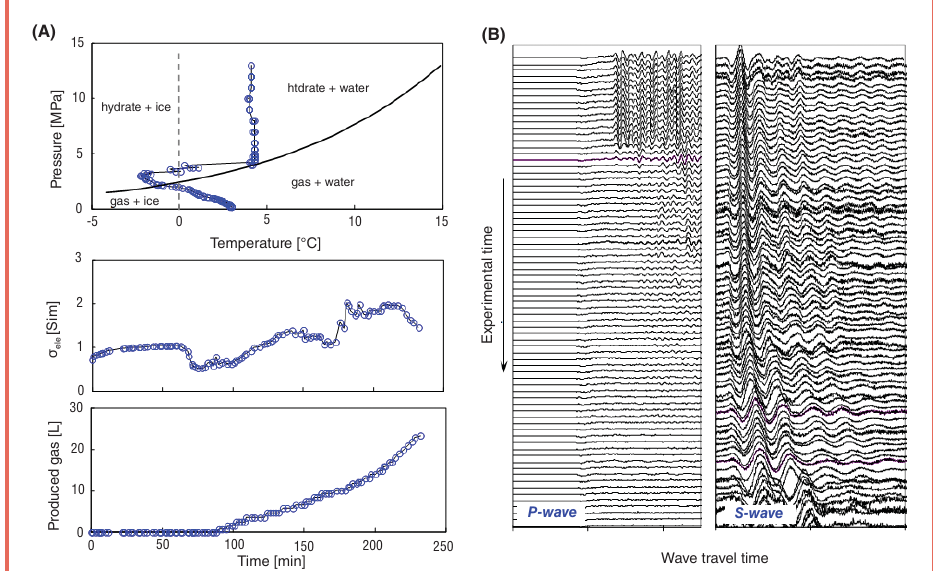
Figure 5. Monitored gas production tests using IPTC: [A] Evolution of pressure, temperature, electrical resistivity, and produced gas (Krishna-Godavari Basin; Yun et al., 2010); [B] Typical wave signatures during gas production: P-wave signatures eventually fade out after gas production; S-waves detect the evolution of the skeleton shear stiffness during hydrate dissociation and gas production (Ulleung Basin; Yun et al.,